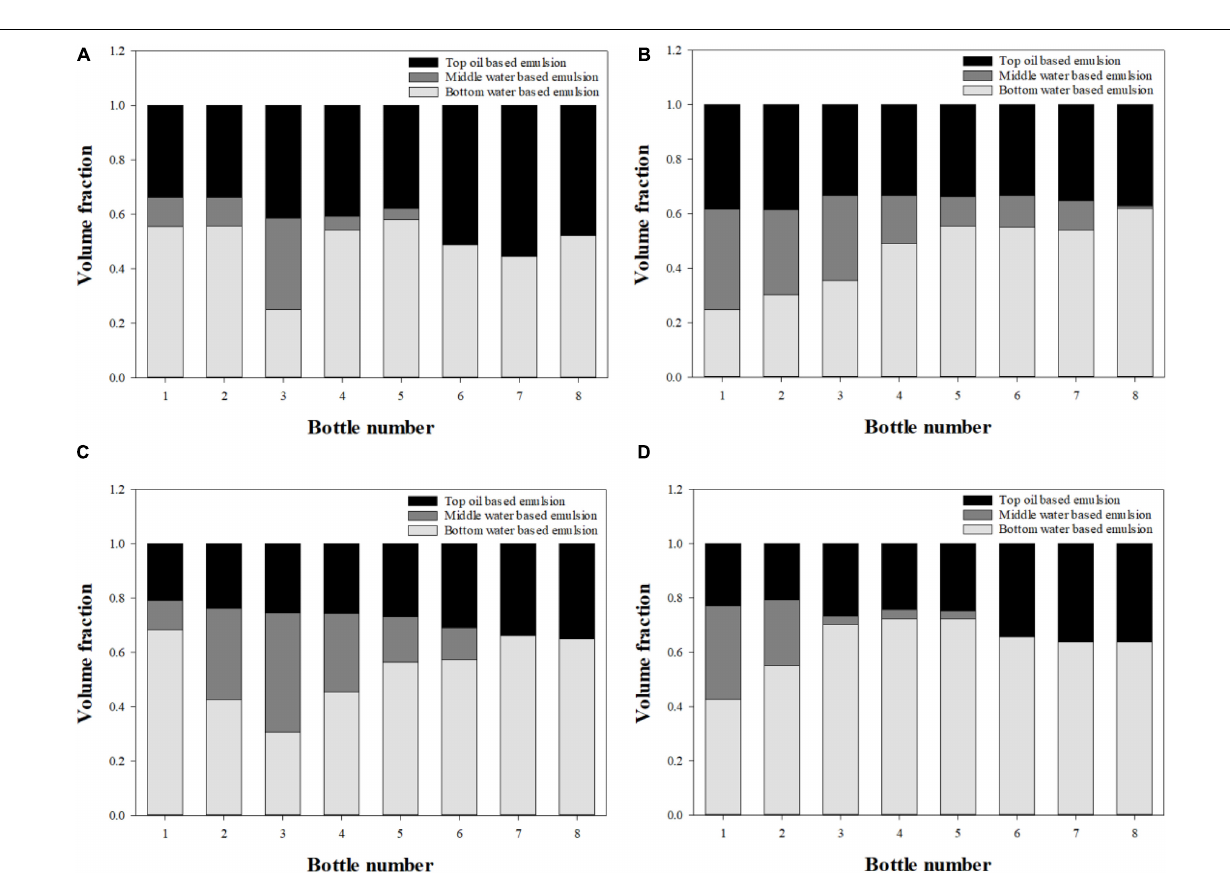
FIGURE 17 | Three phase distribution of bottle test trend study after calibration starting from: (A) NaOH concentration trend study; (B) NaOH salinity trend study; (C) Na 2 CO 3 concentration trend study; (D) Na 2 CO 3 salinity trend